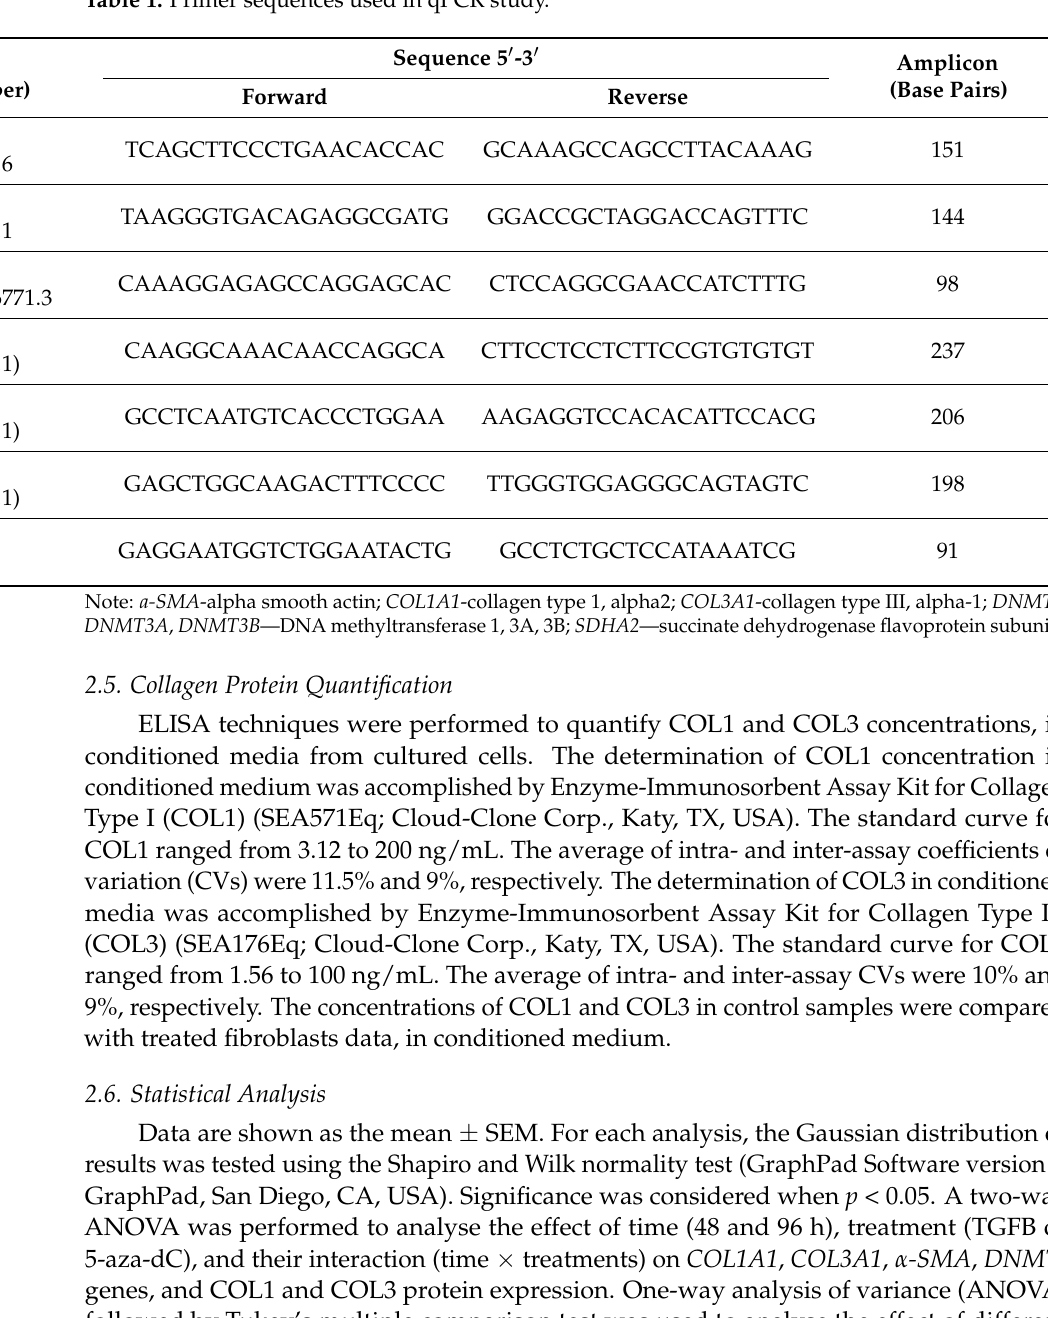
Table 1. Primer sequences used in qPCR